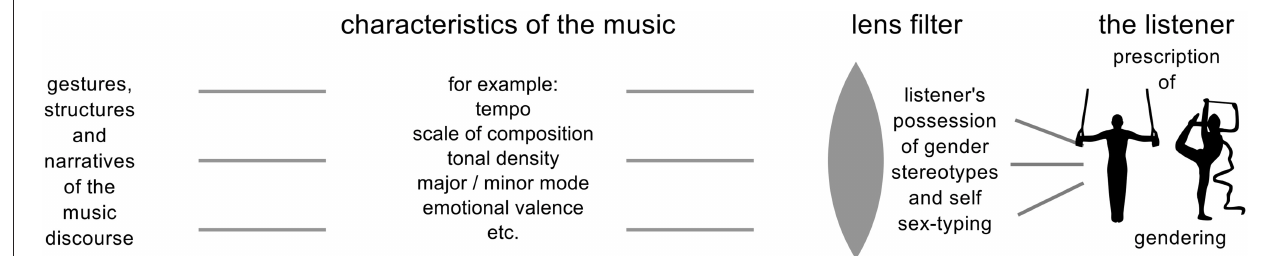
FIGURE 6 | The lens of gender: Musical properties engender gendering.